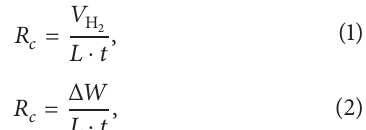
Figure 1: A typical plot of the evolved 𝑉 of Al in alkaline media in absence of inhibitors at 30 ∘ C. [OH − ] = 4.0 moldm −3